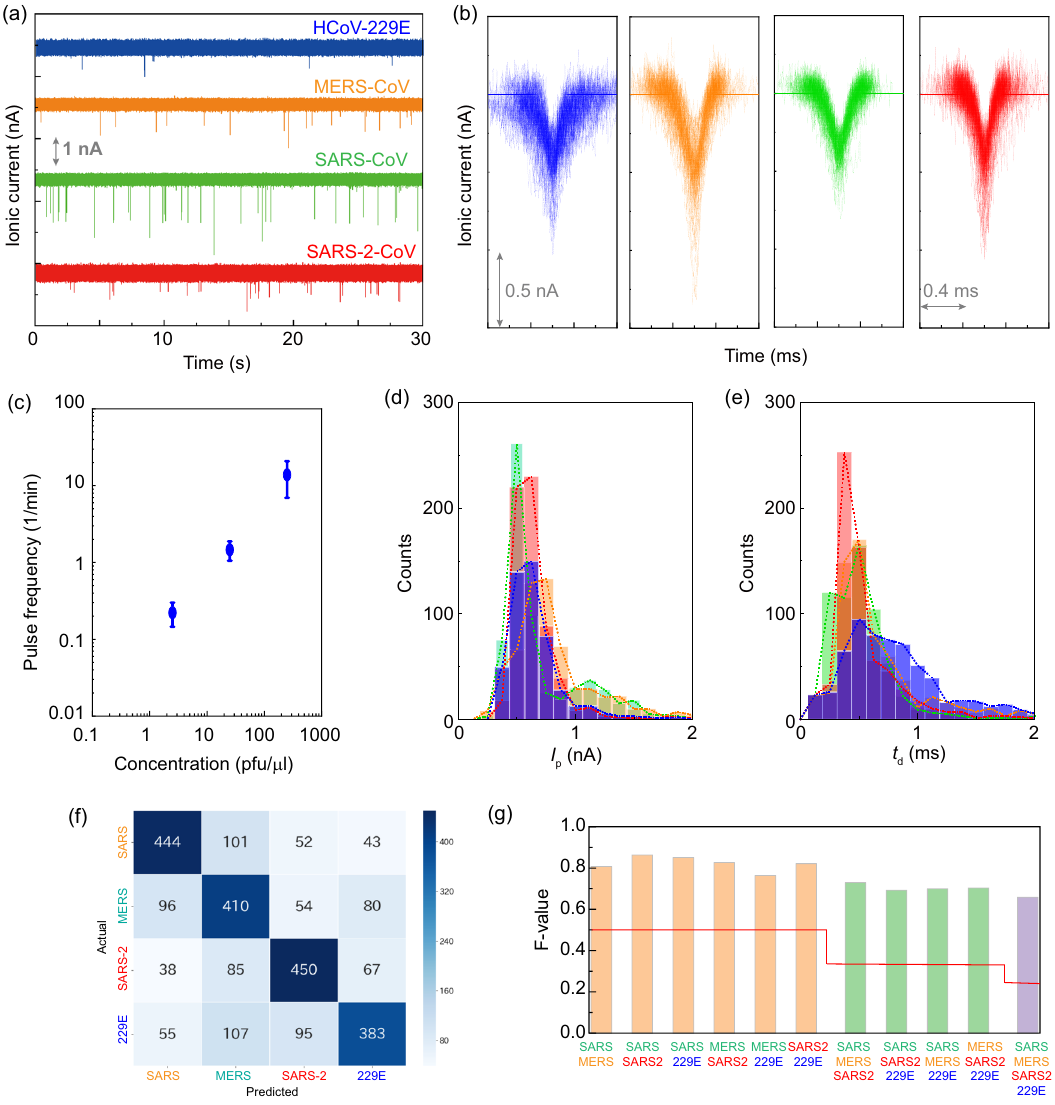
Fig. 2 Identi fi cation of cultured coronavirus. a Ionic current – time traces of cultured HCoV-229E, MERS-CoV, SARS-CoV, and SARS-CoV-2. b Ionic current – time pro fi les, which are obtained by measuring the cultured coronaviruses and overlay 100 waveforms. The color code corresponds to a . c Dependence on the number of detected waveforms on the concentration of HCoV-229E. The number of waveforms per unit minute was calculated based on the number of waveforms obtained during the measurement time of 15min. Three independent samples examined over three independent experiments. Data are presented as mean values ± SD. d , e Histograms of I p and t d of cultured coronaviruses. The color code corresponds to a . f Confusion matrix obtained by machine learning corresponding to the four cultured coronaviruses. The numbers in the matrix indicate the number of waveforms. The machine learning algorithm follows Fig. 1k. The color bar indicates that the darker the blue, the greater the number of pulses. The number of the color bar indicated the number of waveforms. g Identi fi cation accuracy in combinations of two, three, and four types of coronaviruses. Each virus is identi fi ed when the identi fi cation accuracy of the red line or higher is obtained. Orange, green, and purple correspond to two, three, and four virus-identifying F -values, respectively. SARS, SARS2, MERS, and 229E represent SARS-CoV, SARS-CoV-2, MERS-CoV, and HCoV-229E, respectively. Source data of a , b , and d – g are provided as a Source Data fi